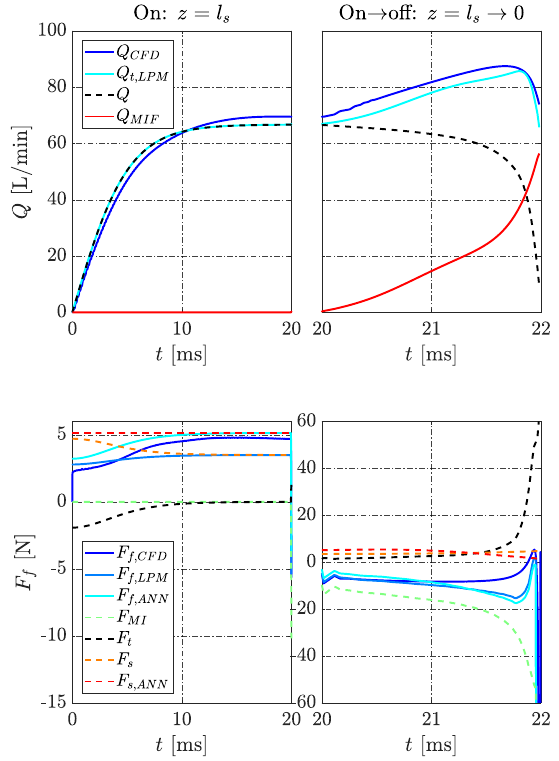
Figure 8: CFD analysis with a constant boundary pres- sure differential of 0.1 bar leading to a build- up of flow. The valve is initially open and initiates closing after 20 ms. F f,ANN relates to the ANN model described in the next sec- tion.